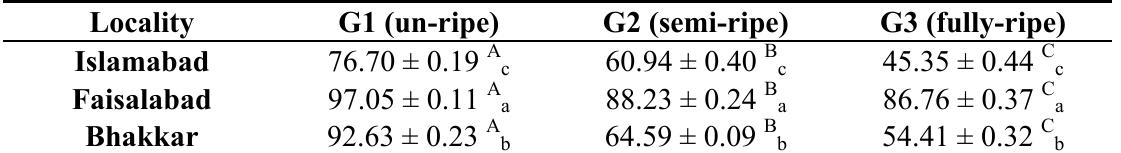
Values are mean ± SD of three samples analyzed individually in triplicate; Superscripts within the row represent significant variation ( p < 0.05) among ripening stages; Subscripts within the column represent significant variation ( p < 0.05) among